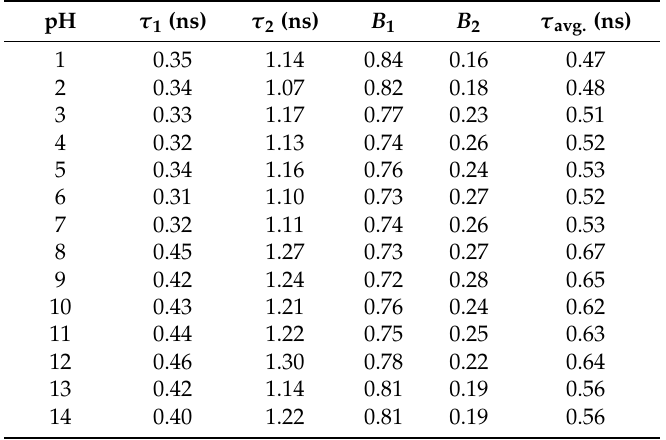
Table 1. Summary of the fitting results of the decay traces for Pdots-20% at various pH values.